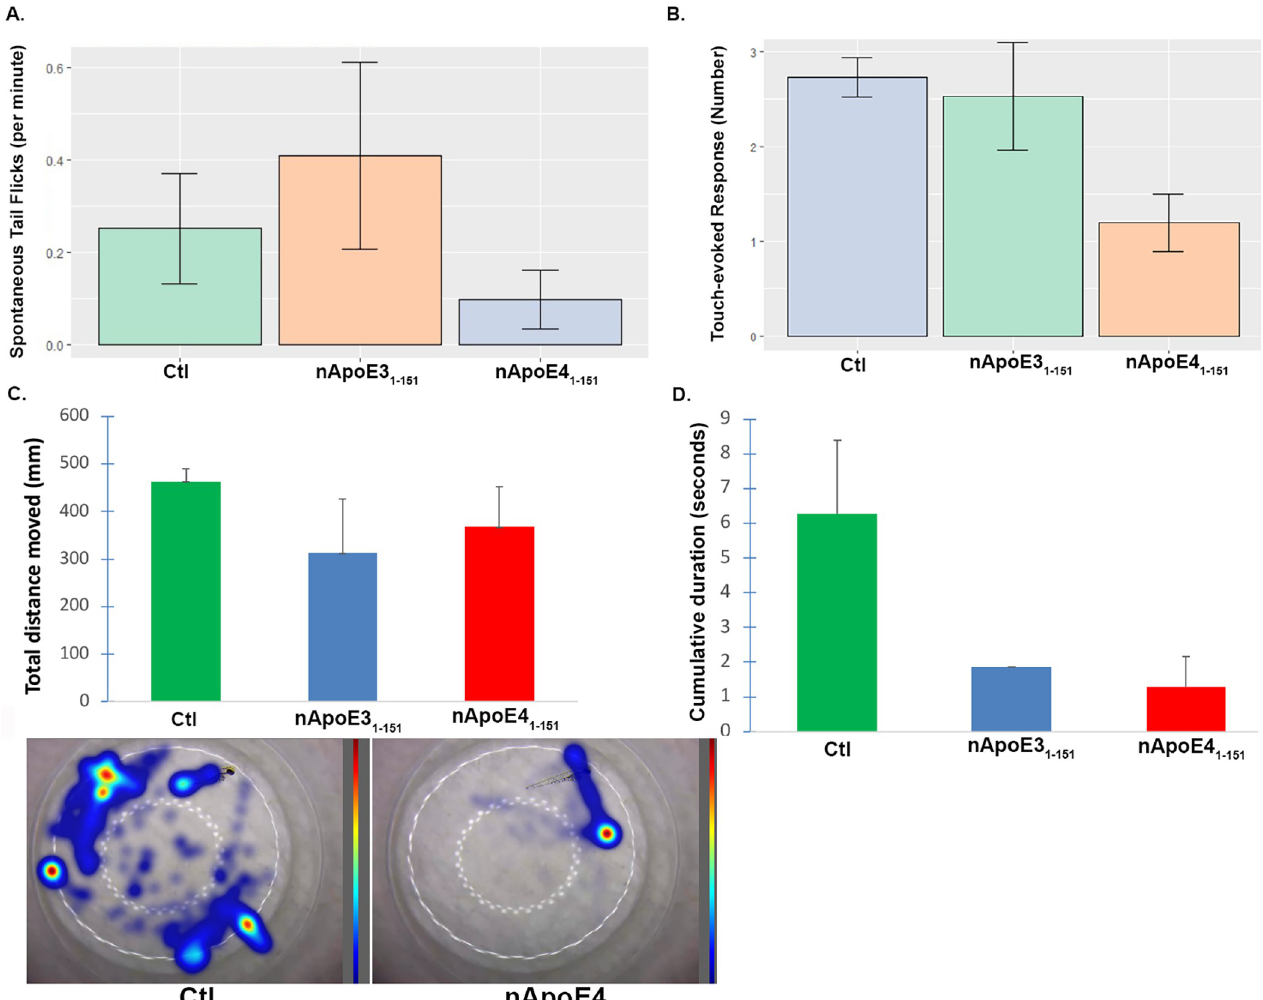
Fig 6. Negative trends in motor behavior in zebrafish following treatment with nApoE4 1-151 . A. Groups for non-treated controls (green bar), nApoE3 1-151 25 μ g/ml (orange bar), and ApoE4 1-151 25 μ g/ml (blue bar)) were assessed via video monitoring to determine number of spontaneous tail flicks per minute that were then averaged per group for each trial. Data are representative of N = 5 trials, for a total of 25 embryos per group, ± SEM. Data depicted show limited spontaneous tail flick activation from every group with no difference detectable between groups ( F( 2,27) = 1.24, p = 0.305 ) . B. Results from the touch-evoked response motor behavior experiment. Non-treated controls had a 90% response rate to the evoked, tactile stimulus, whereas for nApoE4 1-151 -treated groups responded to fewer than 50% of stimuli. No significant difference was observed ( F (12) = 1.482, p = 0.266). C and D. Results from TEMR analyses similar to Panels A and B with the exception that in this case, total distance traveled (C) or the total time swimming (D) were recorded via video monitoring and using Noldus tracking software. For Panel C, representative heat maps of individual larvae representing either wild-type controls (left Panel), or a low-performing nApoE4 1-151 -treated zebrafish (right Panel). Each bar represents the average total distance traveled or averaged cumulative duration during 5 independent trials, for a total of 15 embryos per group, ( ± SEM). No significant differences were observed, with for example the Ctl group vs. nApoE4 1-151 having a p value = 0.08 in Panel C. P-values for Panel D were Ctl vs. E3 fragment = 0.86 and Ctl vs. E4 fragment =